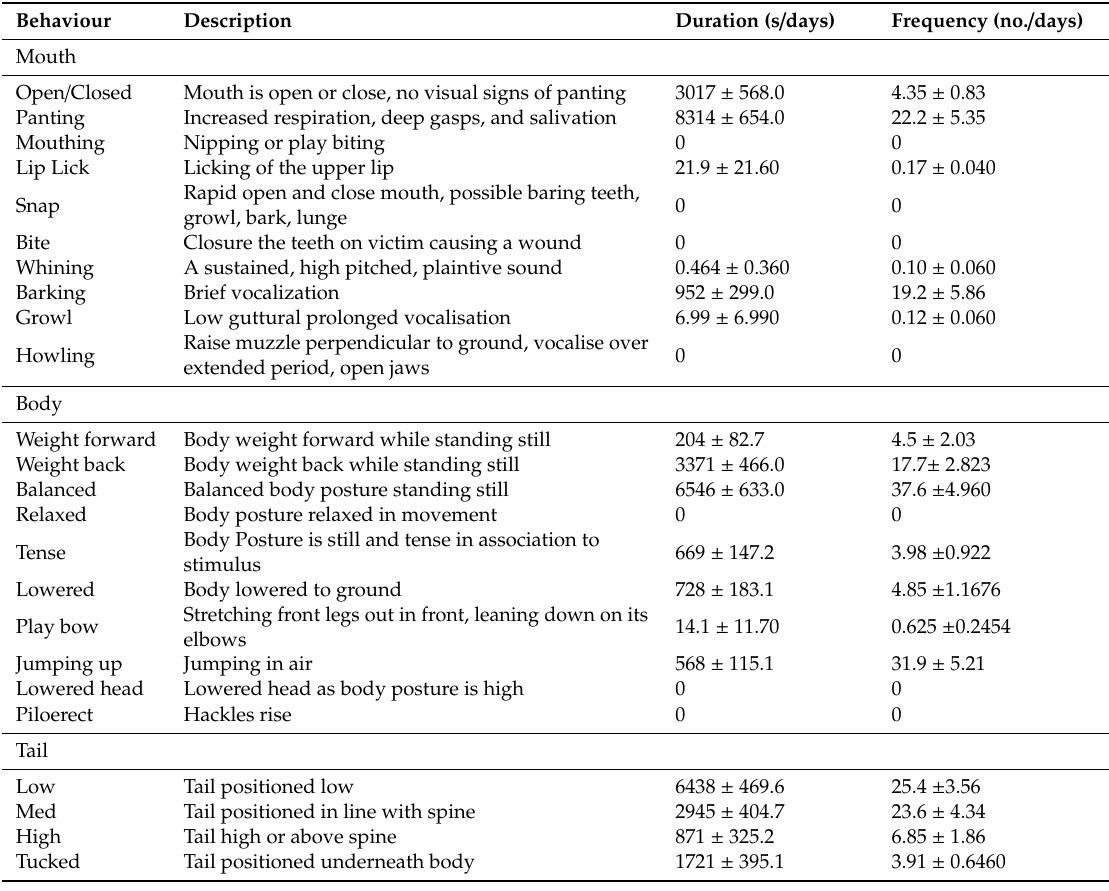
Table 2. Behaviours measured, their descriptions and mean values ( ± SEM) for duration and frequency during kennel